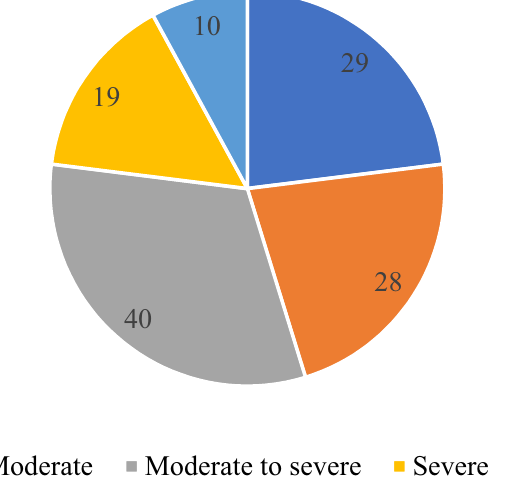
Figure 3. The numbers of affected ears (126 ears) in different hearing level group.